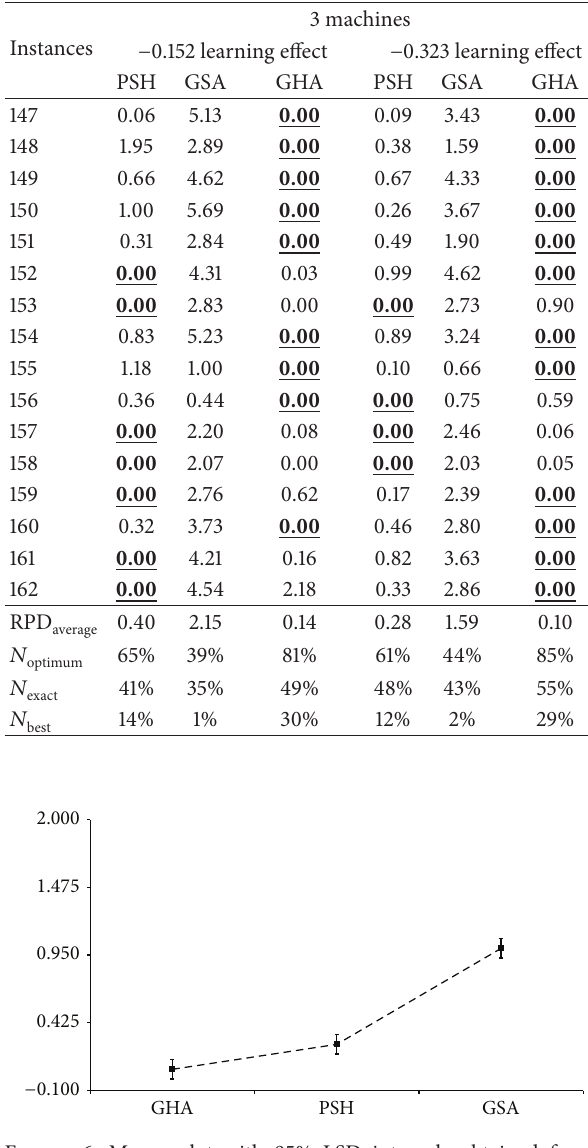
Figure 6: Means plot with 95% LSD intervals obtained for 6- machine